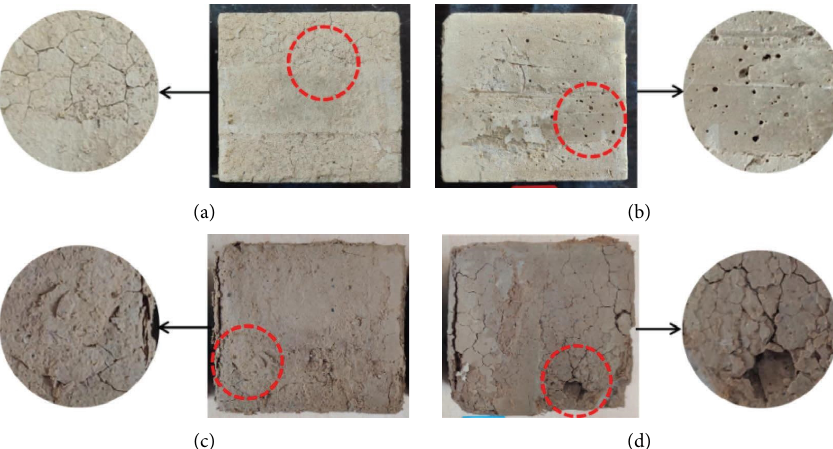
Figure 8: Te apparent characteristics of the glass fber-reinforced cemented soil in a salt solution environment after 5 cycles in (a) water; (b) potassium acetate; (c) magnesium chloride; (d) sodium